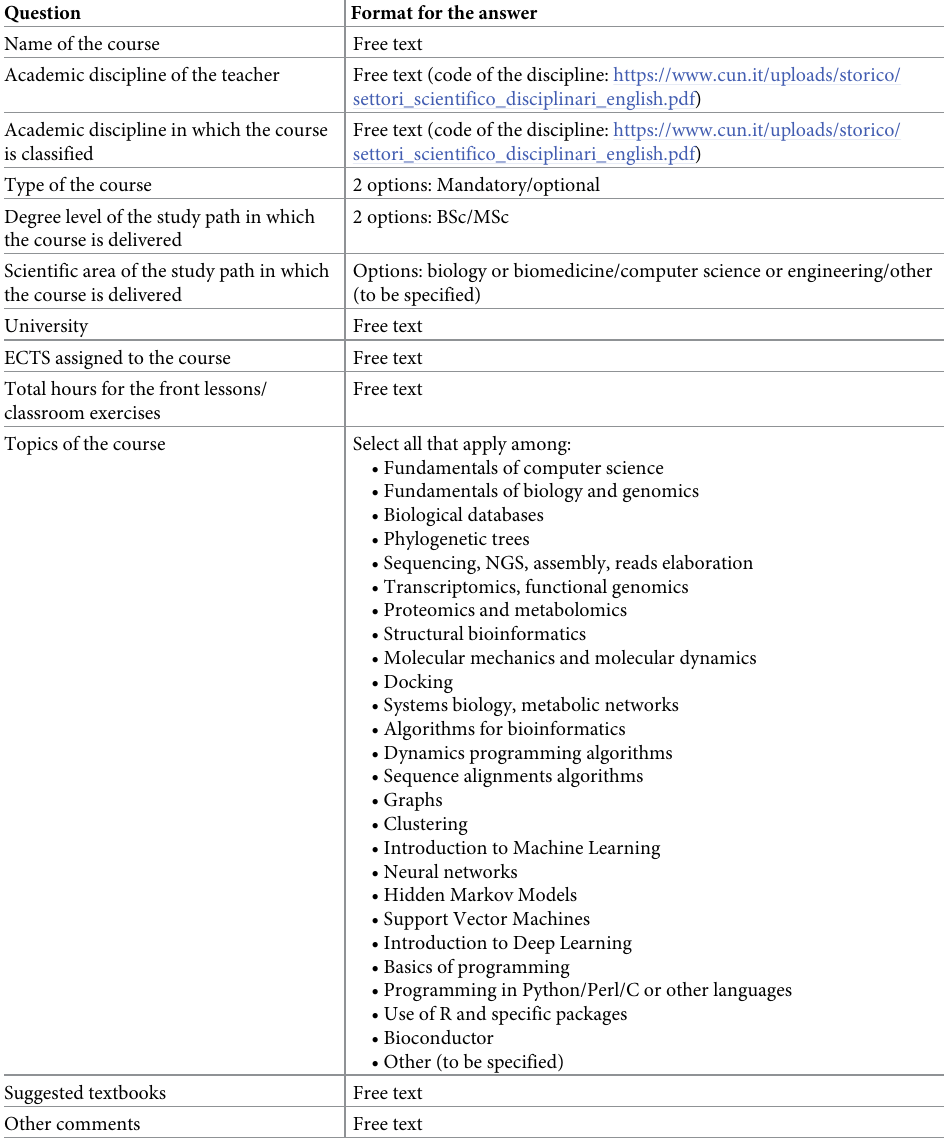
Table 1. Questions included in the survey sent to the Bioinformatics Italian